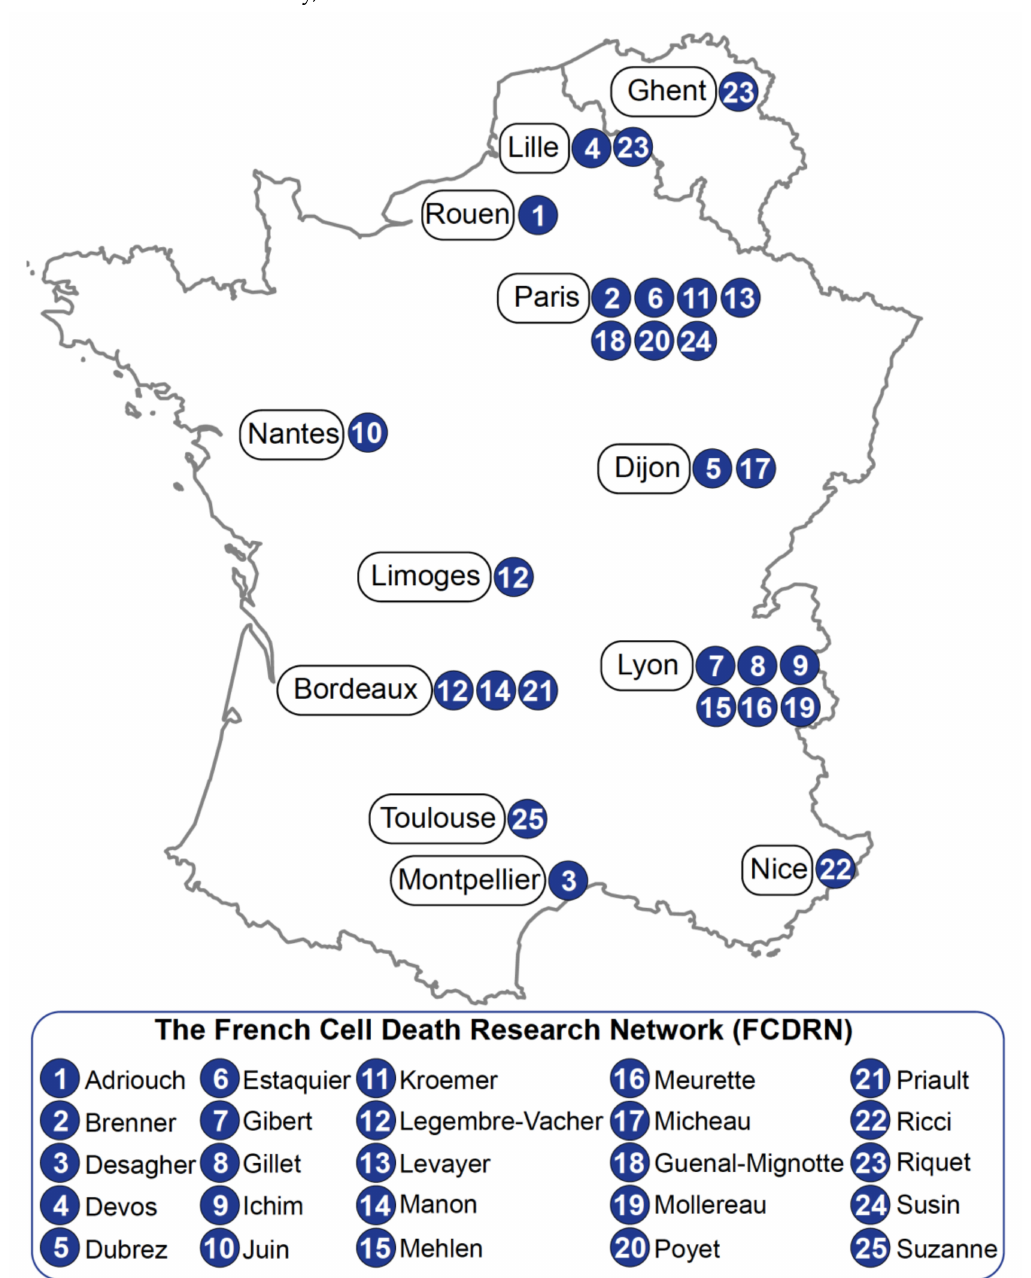
Figure 1. Geographical distribution of the FCDRN research